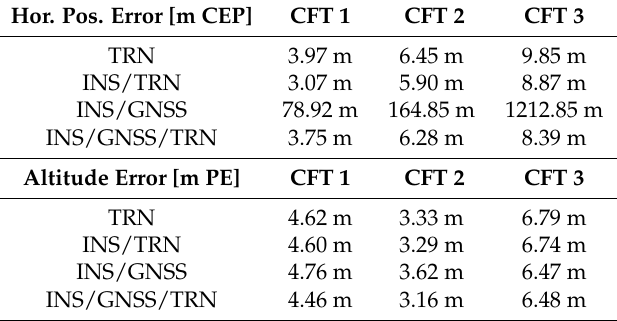
Table 5. Experiment results of the captive flight tests in a GNSS-denied